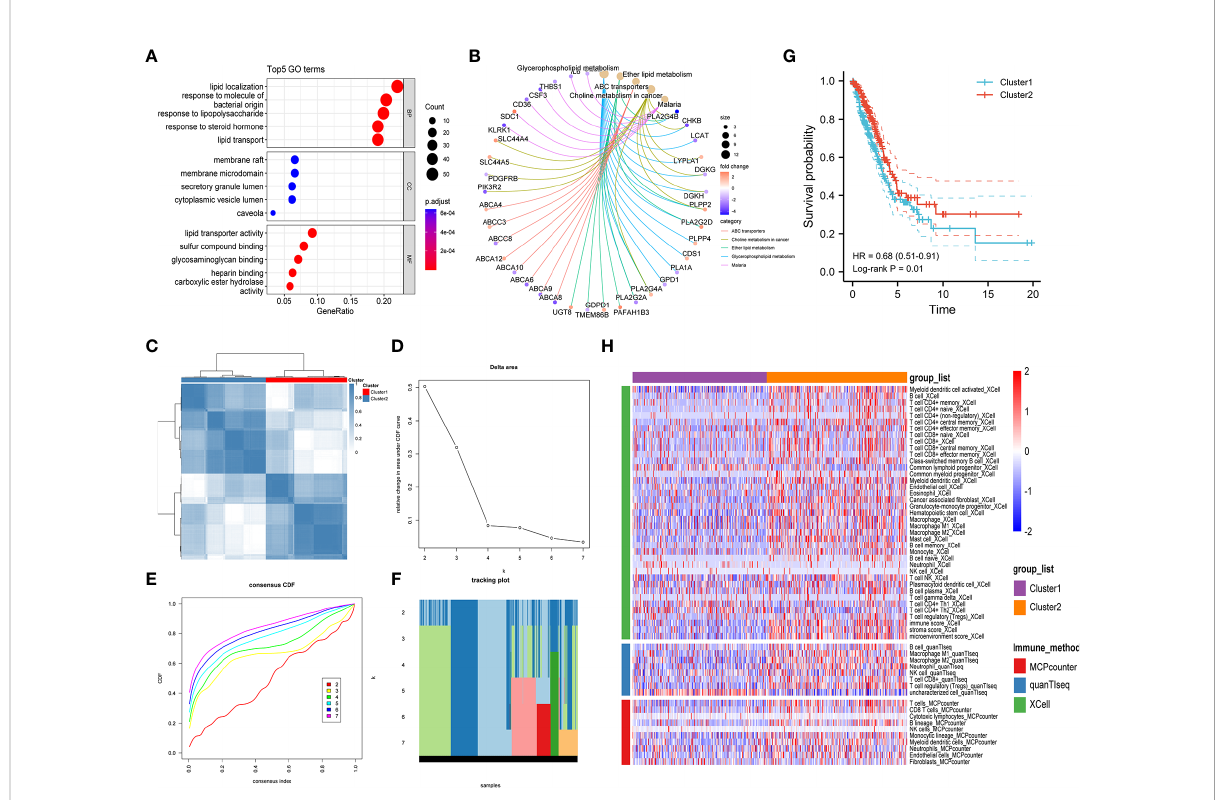
FIGURE 2 Exploration of lipid metabolism-related DEGs. Gene ontology (GO) functional annotation (A) and KEGG pathway enrichment analysis (B) of lipid metabolism-associated DEGs. (C) Heatmap of unsupervised consensus clustering. (D) The plot of changes in the relative area under the cumulative distribution function (CDF) curve from k = 2 to 7. (E) Consensus CDF curve plot. (F) The tracking plot of the clustering samples. (G) Kaplan – Meier curves for the overall survival of LUAD patients in different clusters. (H) Comparison of immune cell in fi ltration patterns between different clusters performed by the xCell, quanTIseq, and MCPcounter